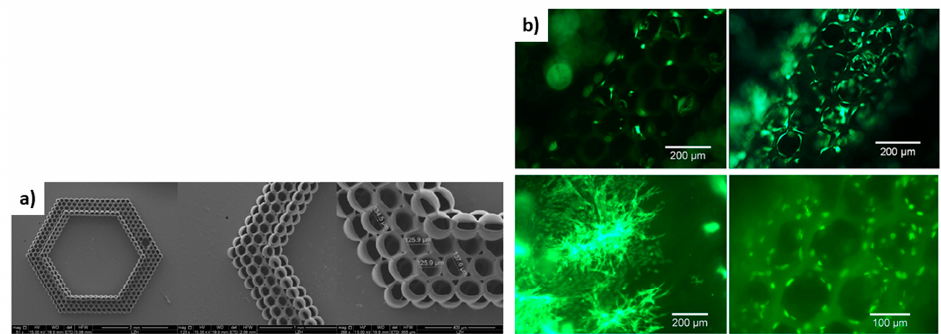
Figure 15. ( a ) Fabricated fibrin gel sca ff old with hexagonal shape. ( b ) Cells cultured for seven days